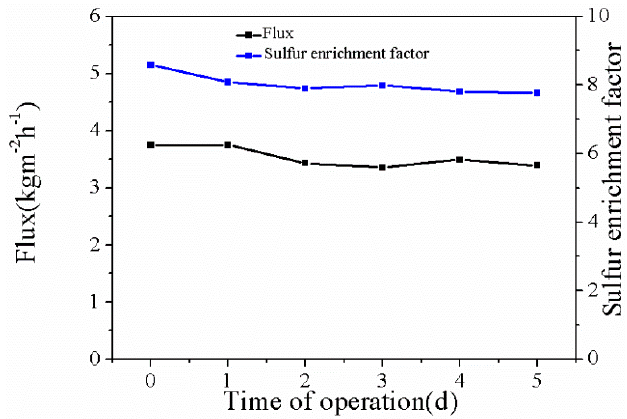
Figure 11. Long-term stability of the CuBTC-filled PEG MMMs.